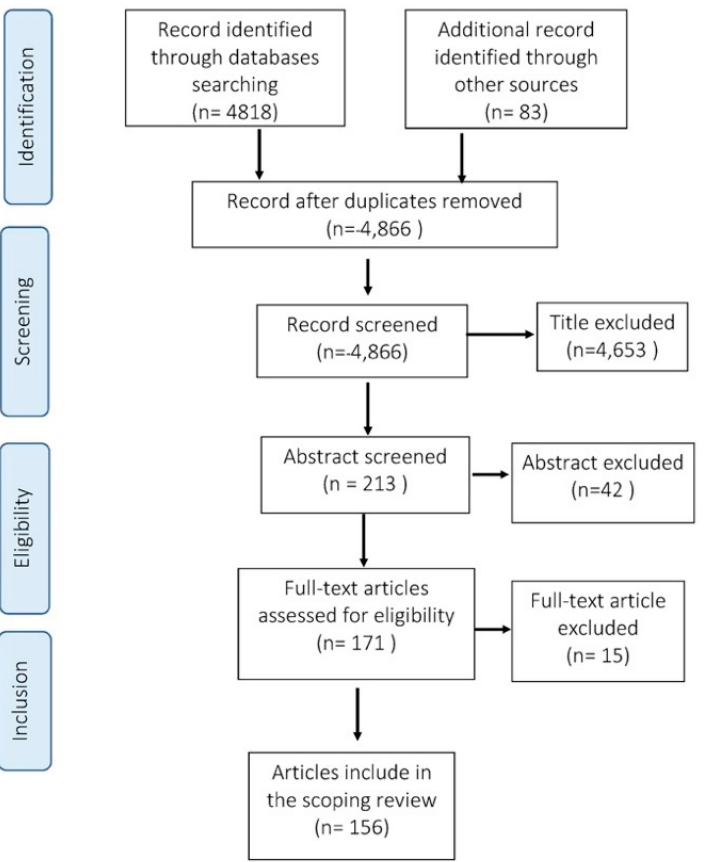
Figure 1. PRISMA flowchart shows the articles identified from the literature search from 1991 to